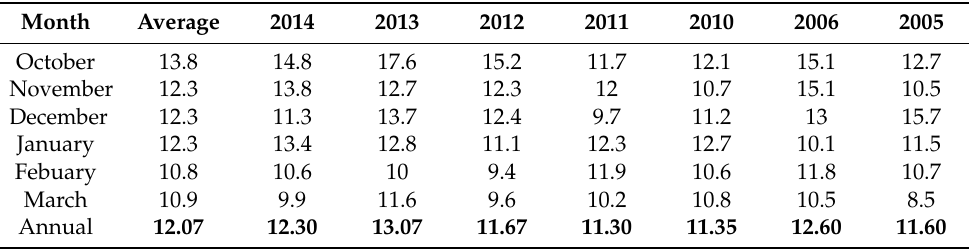
Table 8. Comparison of mean monthly diurnal temperature differences for each simulation year and 20 year average for Penrith.